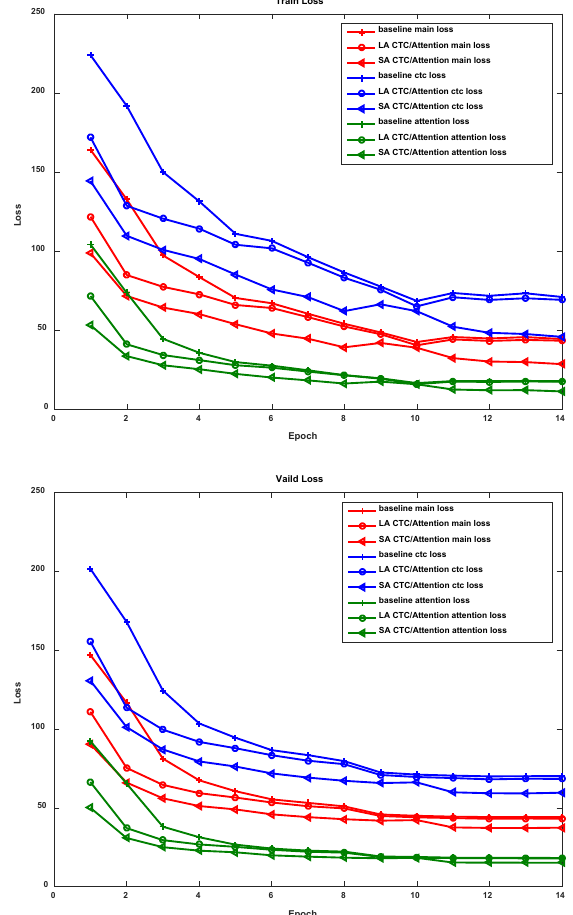
Figure 2. The train and valid losses of the baseline, LA CTC/Attention, and SA CTC/Attention architectures for